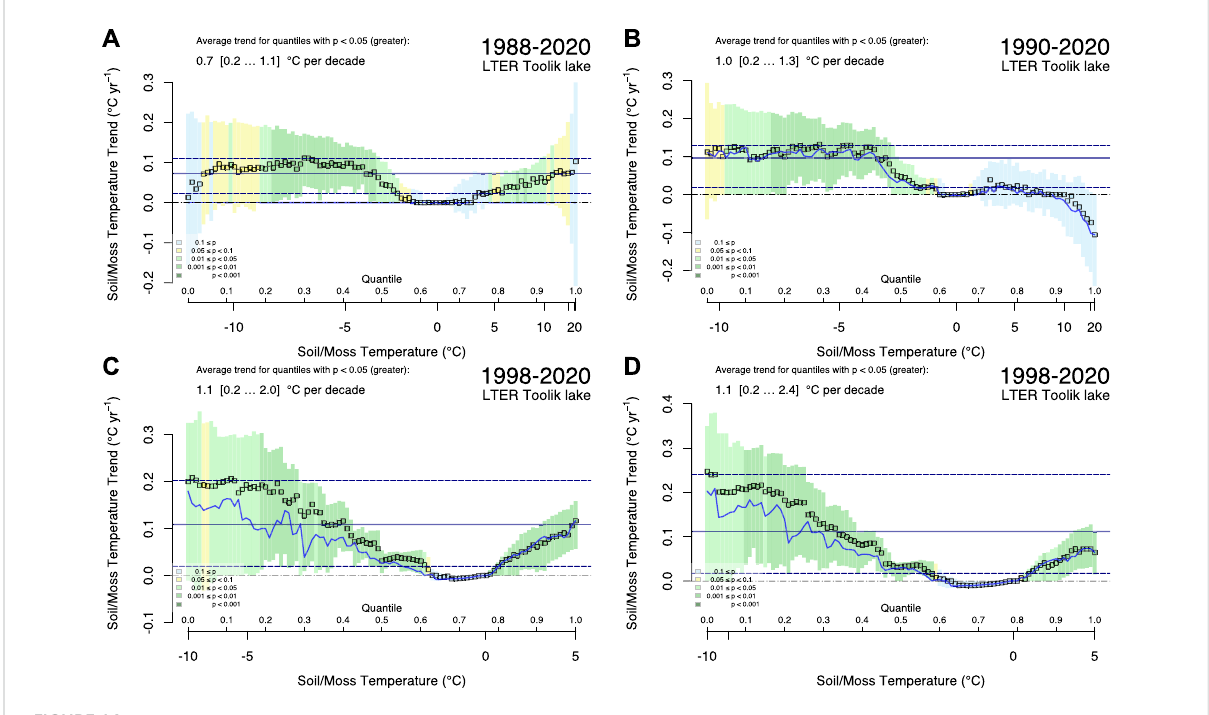
FIGURE 14 Quantile regression trend estimates of (A,B) moss temperatures of two replicates (two-sided test), and (C,D) soil temperatures at 1.5 m depth (typical maximum depth of active layer). Display as in Figure